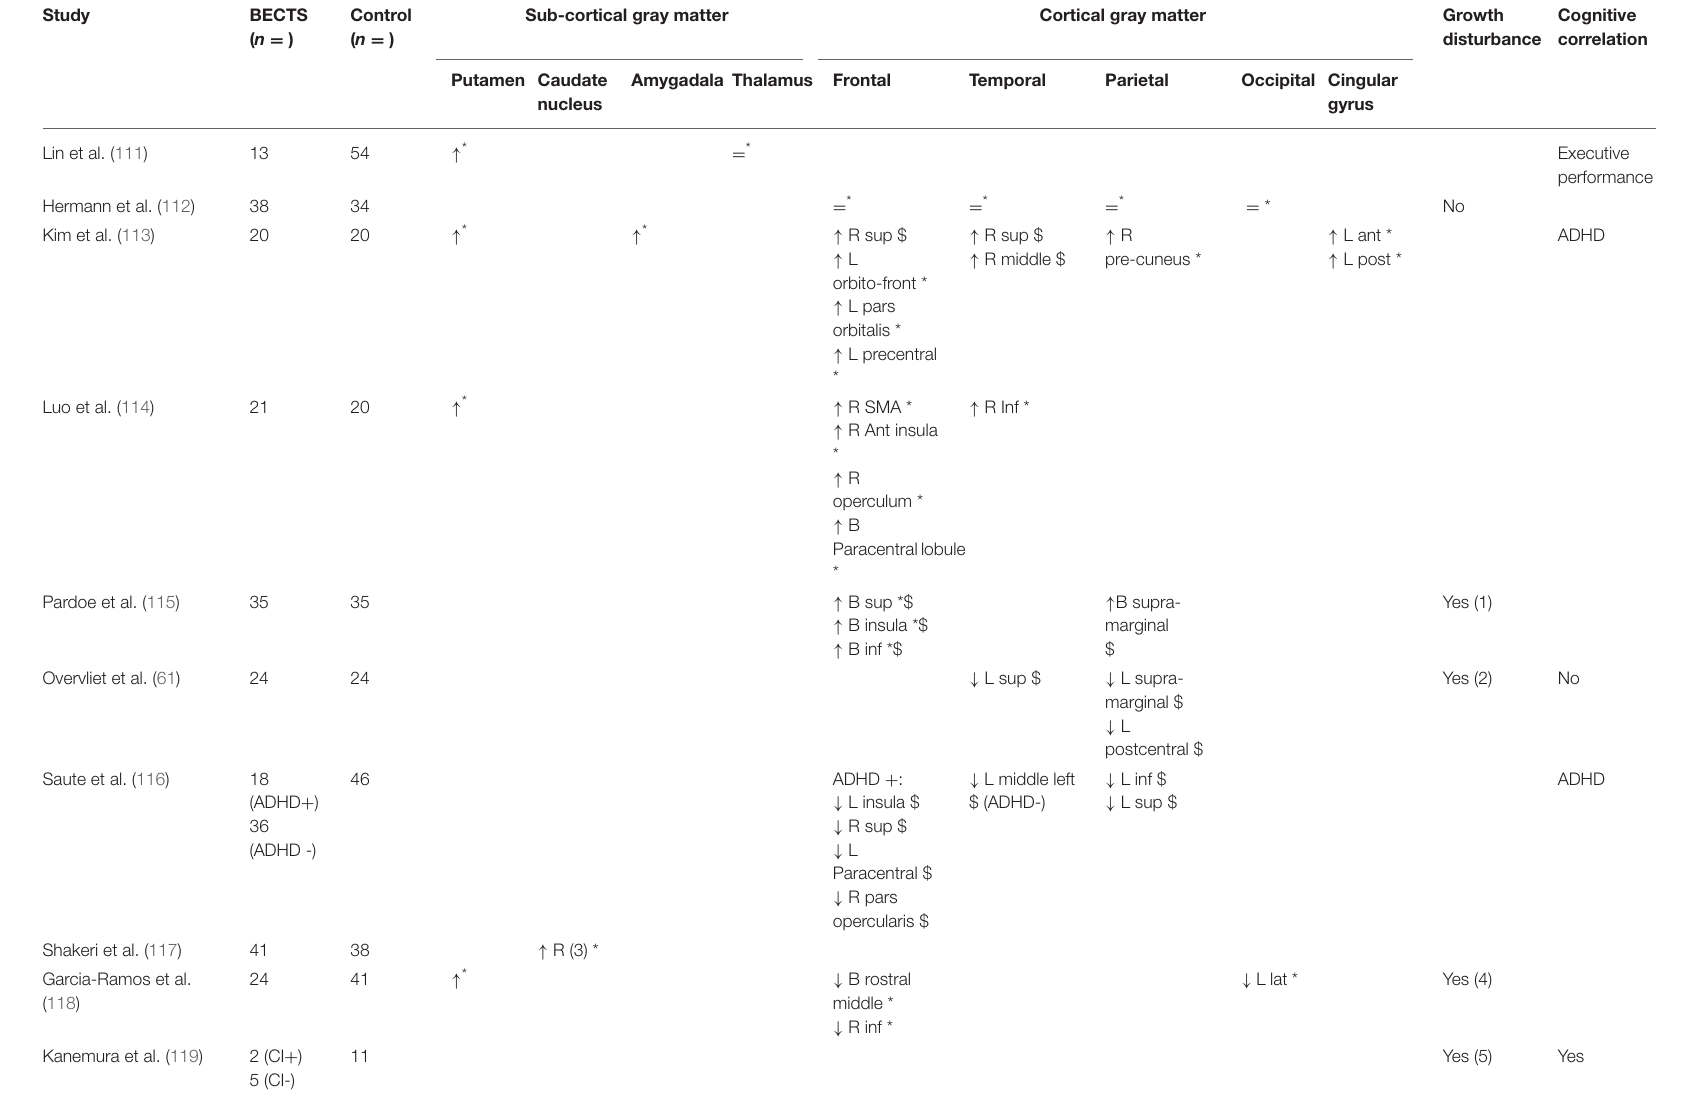
TABLE 1 | Structural brain disorganization in